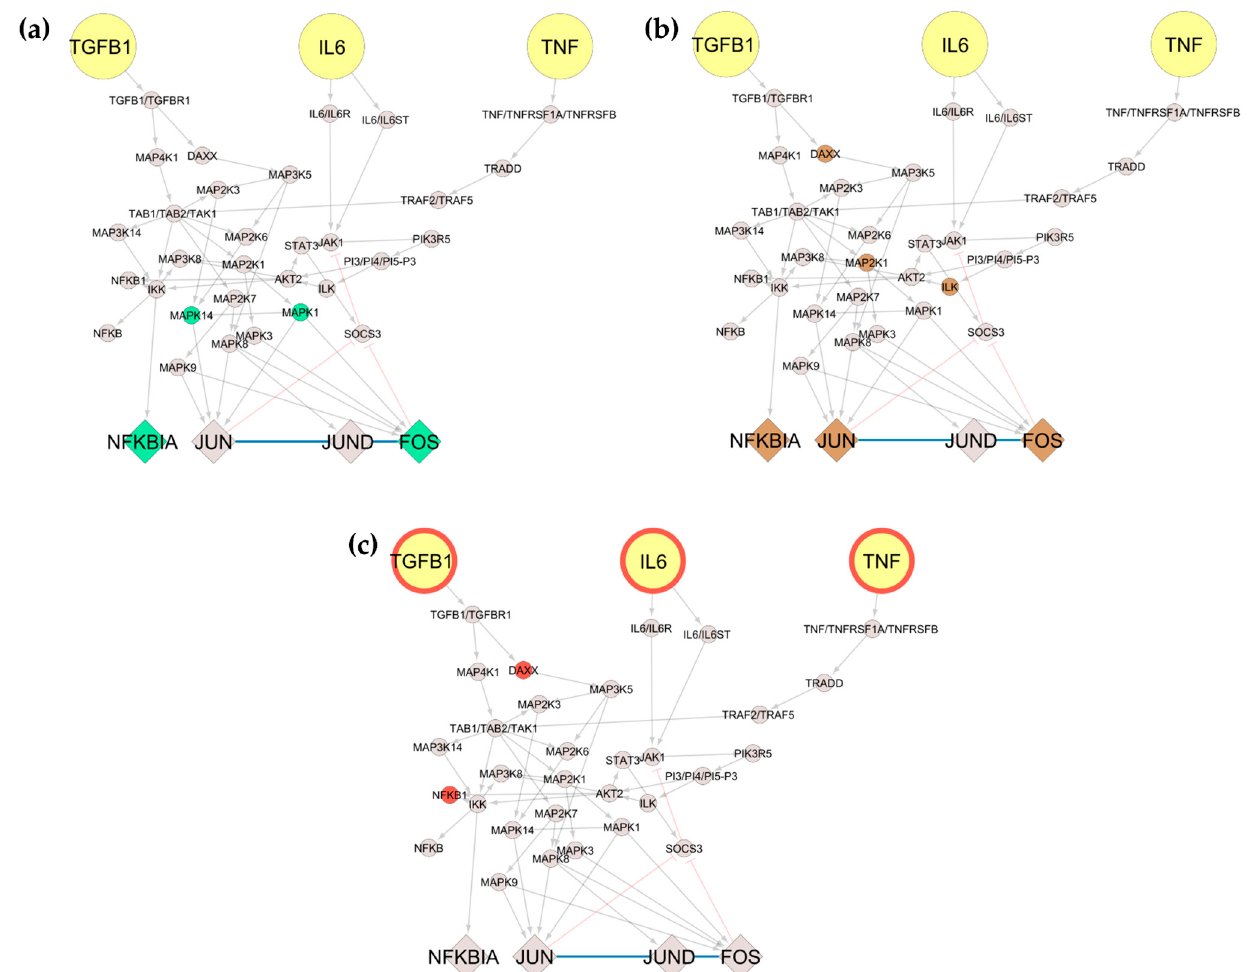
Figure 5. Subnetwork extraction of target molecules (TGFB1, IL6, and TNF) from the global network for RA. We focused on TGFB1, IL6, and TNF (coloured in yellow) and their downstream neighbours (depicted in round shapes) until reaching the first transcription factor (depicted in diamond shapes). Then, we projected on the network ( a ) DEG from responders/non-responders RA patients to anti-TNF treatment, as shown in green (4); ( b ) DEG after/before anti-TNF treatment of RA patients is shown in brown (6); and ( c ) DisGeNET variants are shown in red (5).